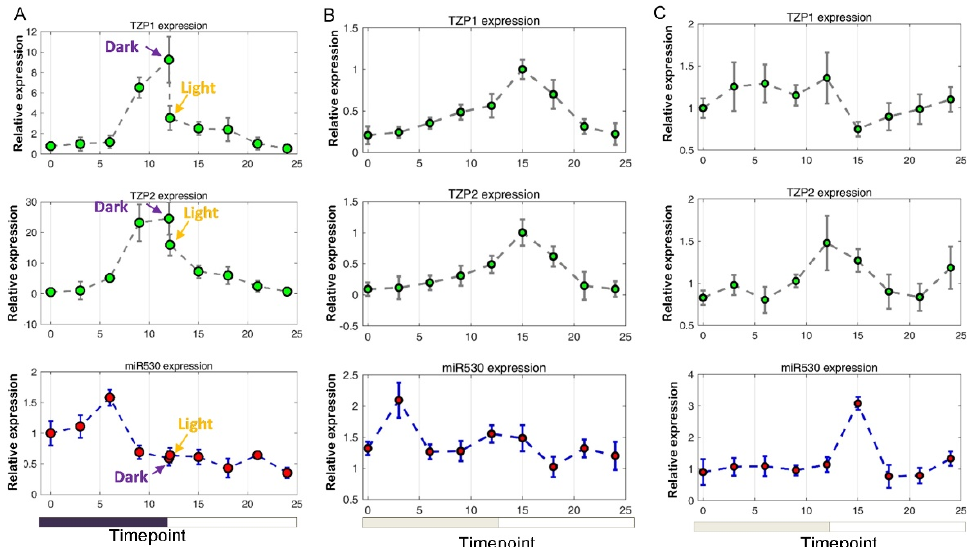
Figure 5. The expression patterns of miR530, KmTZP1 and KmTZP2 determined by the circadian clock. ( A ) The diel expression of miR530 and its targets ( KmTZP1 and KmTZP2 ) under the normal light-dark cycle. The interval of time-points is 3 h, and three biological replicates are used for gene expression analysis. The 5 min before and after the light-on are sampled for gene expression analysis (indicated by arrows). ( B ) The diel expression of miR530 and its targets ( KmTZP1 and KmTZP2 ) under constant light conditions, which is performed immediately after the normal light–dark cycle as indicated in ( A ). ( C ) The diel expression of miR530 and its targets ( KmTZP1 and KmTZP2 ) in the second day of constant light conditions. Each panel indicates a sampling cycle of 24 h.